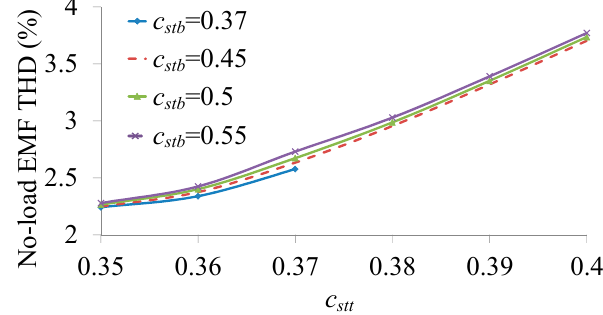
Figure 10. THD of no-load EMF with different c stt and c stb .